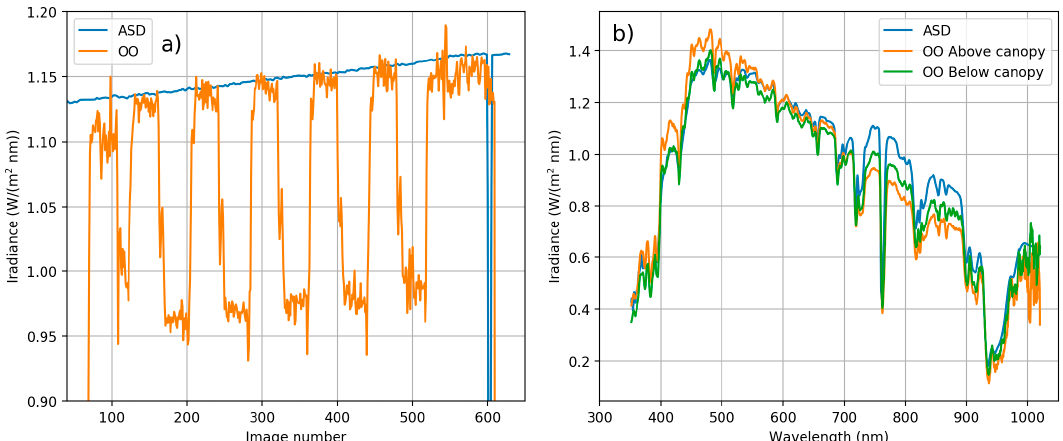
Figure 16. ( a ) Mean value of 600–700 nm irradiance spectra of the ASD and Ocean Optics (OO) for each FPI image acquisition time during the campaign. Irradiance increases toward the end of the flight due to rising solar angle. The steps in OO data are caused by UAV flying in different directions and thus the UAV and irradiance sensor tilting. ( b ) Effect of tree canopy to the irradiance spectrum. ASD is affected by the proximity of the tree canopies compared to the OO which is above canopy.